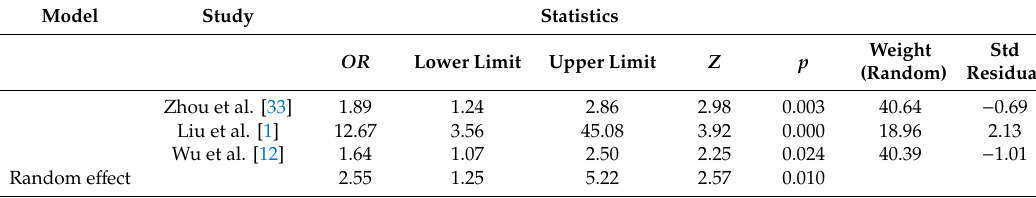
Table 2. Summary e ff ect sizes for low-density lipid cholesterol (LDL-C) serum levels and Alzheimer’s disease (AD).